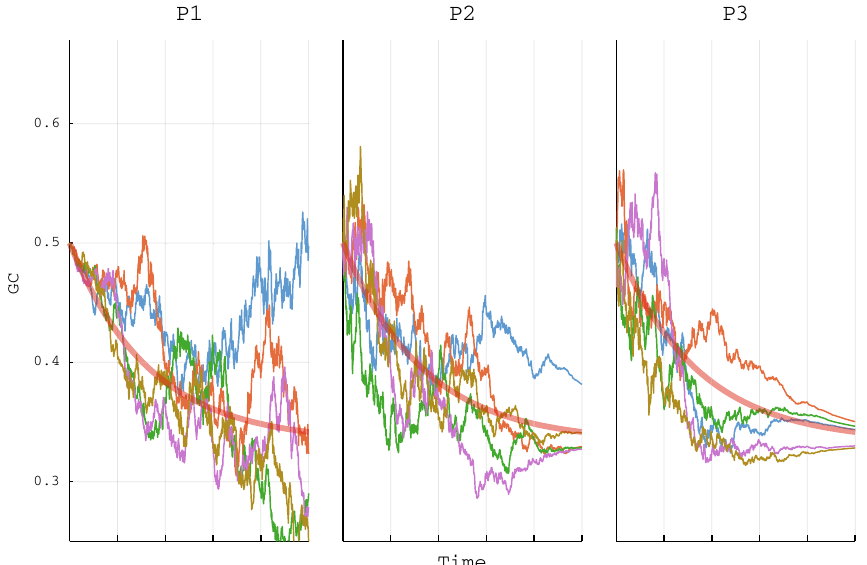
Figure 1. The figure demonstrates three different (P1–P3) evolutionary scenarios, each realized 5 times, for the model describing the evolution of genomic GC content (vertical axis) of a species over time t (horizontal axis) as a consequence of AT/GC mutation rates. The thick red line represents the deterministic model without the Brownian motion term. All parameters are the same for all scenarios (i.e. a = − 2 , b = 1 , F 0 = 0.5 and T = 1 ) except for the function c ( t ) that determines the influence of the random perturbations on the AT/GC mutation √ 1 t , Panel P2: c ( t ) = 1 2 ( T − t ) , Panel P3: c ( t ) = 1 2 ( T − t ) 2 rates. Panel P1: c ( t ) = 2